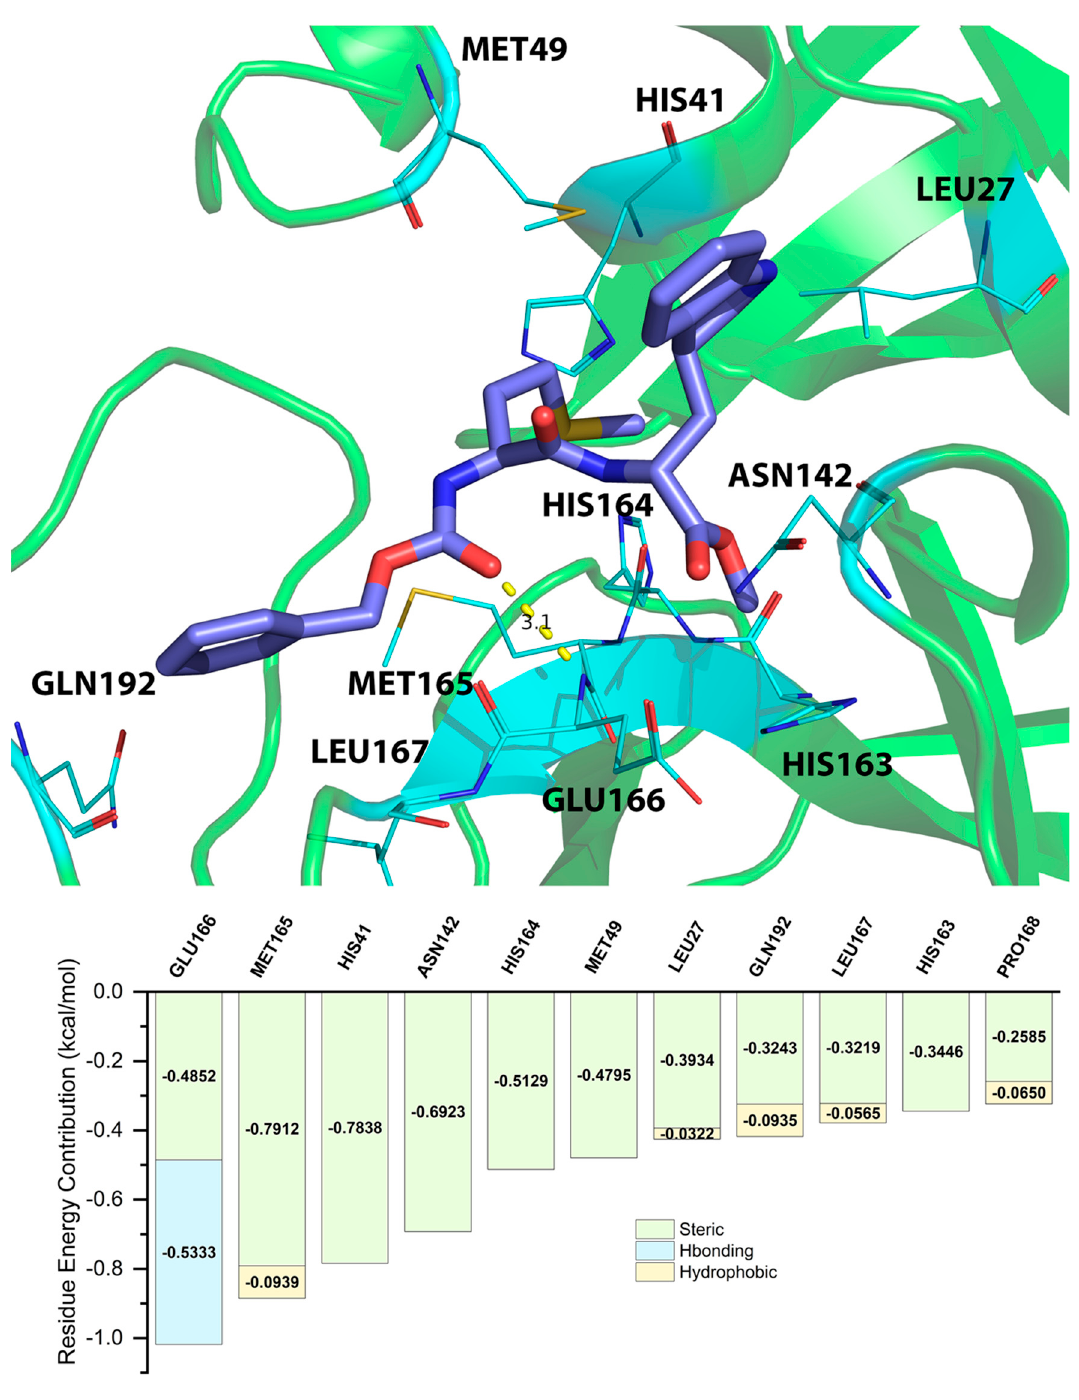
Figure 3. Binding poses between ZINC09033700 and 3CL pro of SARS-CoV-2 predicted by MD simulation and residue energy contribution between ZINC09033700 and 3CL pro of SARS-CoV-2 predicted by MCCS.